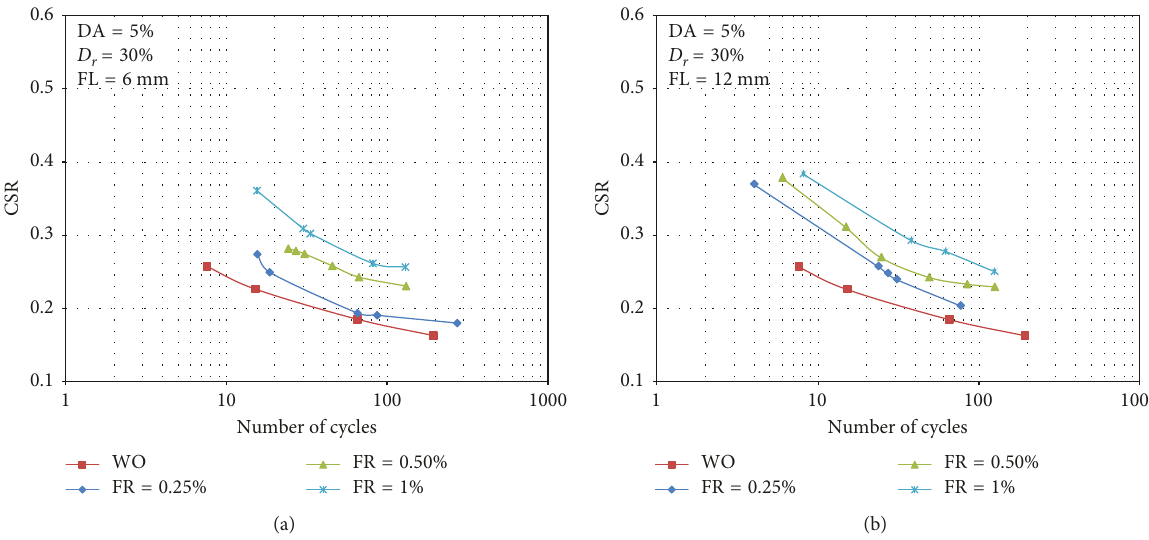
Figure 4: Variation of CSR with the number of cycles considering the effect of fiber length (a) FL fibers, FR: fiber ratio, D r